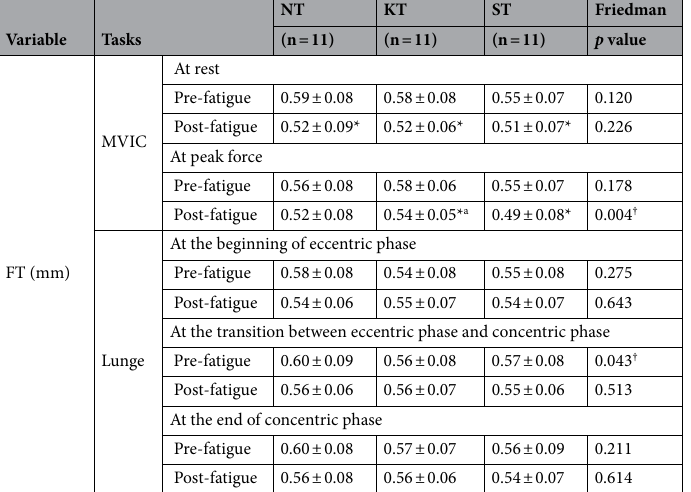
Table 2. Fascia thickness of medial gastrocnemius muscle. Data are presented as means + SD. NT No taping; KT Kinesio taping; ST Sham taping; SD Standard deviation; MVIC Maximum voluntary isometric contraction. *Statistically significant difference pre- and post-fatigue (Wilcoxon signed-rank test, p < 0.05). † Statistically significant difference between NT, KT and ST groups (Friedman test, p < 0.05). a Statistically significant difference to the ST group (Wilcoxon signed-rank test, p <